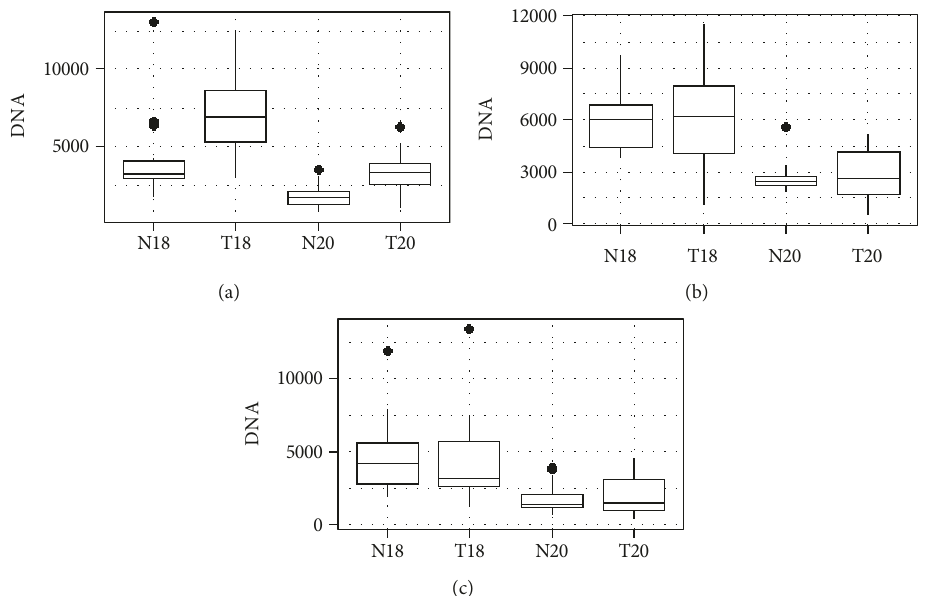
Figure 1: DNA content by tissue type and needle gauge in (a) lung tumors, (b) liver tumors, and (c) kidney tumors (N18=normal tissue/18 gauge, T18=tumor tissue/18 gauge, N20 =normal tissue/20 gauge, and T20=tumor tissues/20 gauge). The dark bar represents median DNA quantity, the surrounding box encompasses the 25 – 75% interquartile range (IQR), and the brackets re fl ect 1.5 ∗ IQR. Diamonds represent statistical outliers.